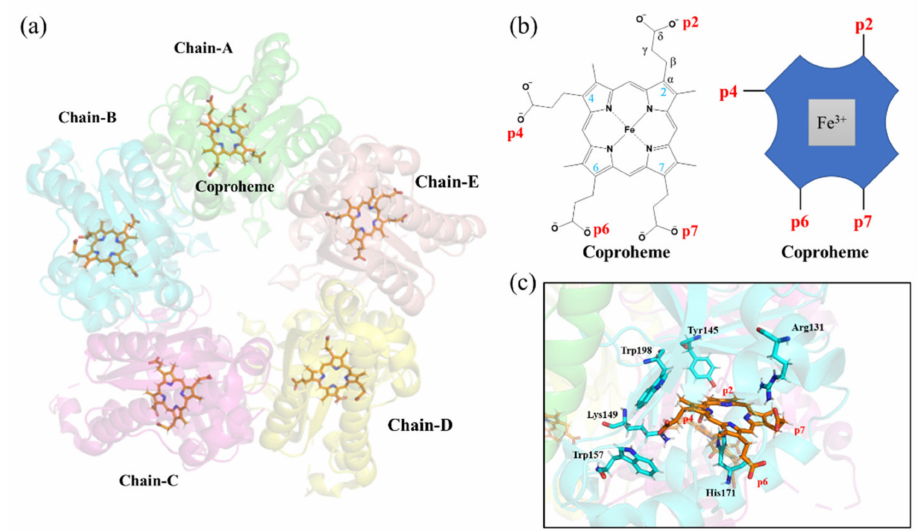
Figure 1. Coproheme–GsChdC complex highlighting the relevant binding orientations for the substrate. ( a ) Cartoon representation of pentamer assemblies of representative crystal structures of the coproheme–GsChdC complex: different chains of GsChdC are shown in green for chain A, cyan for chain B, magenta for chain C, yellow for chain D and wheat for chain E, respectively. The coproheme cofactor is depicted as orange sticks. ( b ) The chemical structure of coproheme (left) and its schematic representation (right). ( c ) Close-up view of the active site structures binding with a coproheme, highlighting the positions of the side chains for the neighboring Tyr145, Arg131, Lys149, Trp157, His171 and Trp198 in cyan sticks and coproheme in orange